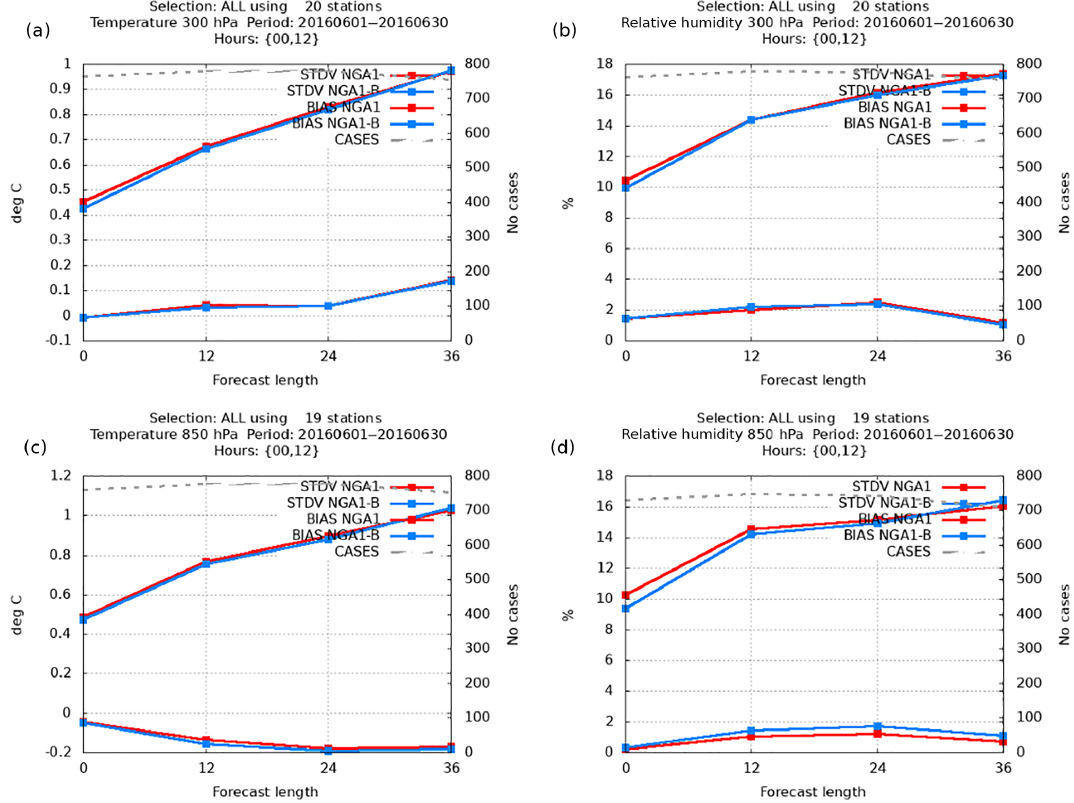
Figure 11. Bias and standard deviation of temperature (unit: K) and relative humidity (unit: %) as a function of forecast range. Scores for temperature (a, c) and relative humidity (b, d) at the vertical levels of 300hPa (a, b) and 850hPa (c, d) . Scores are for experiments D1 (red) and D2